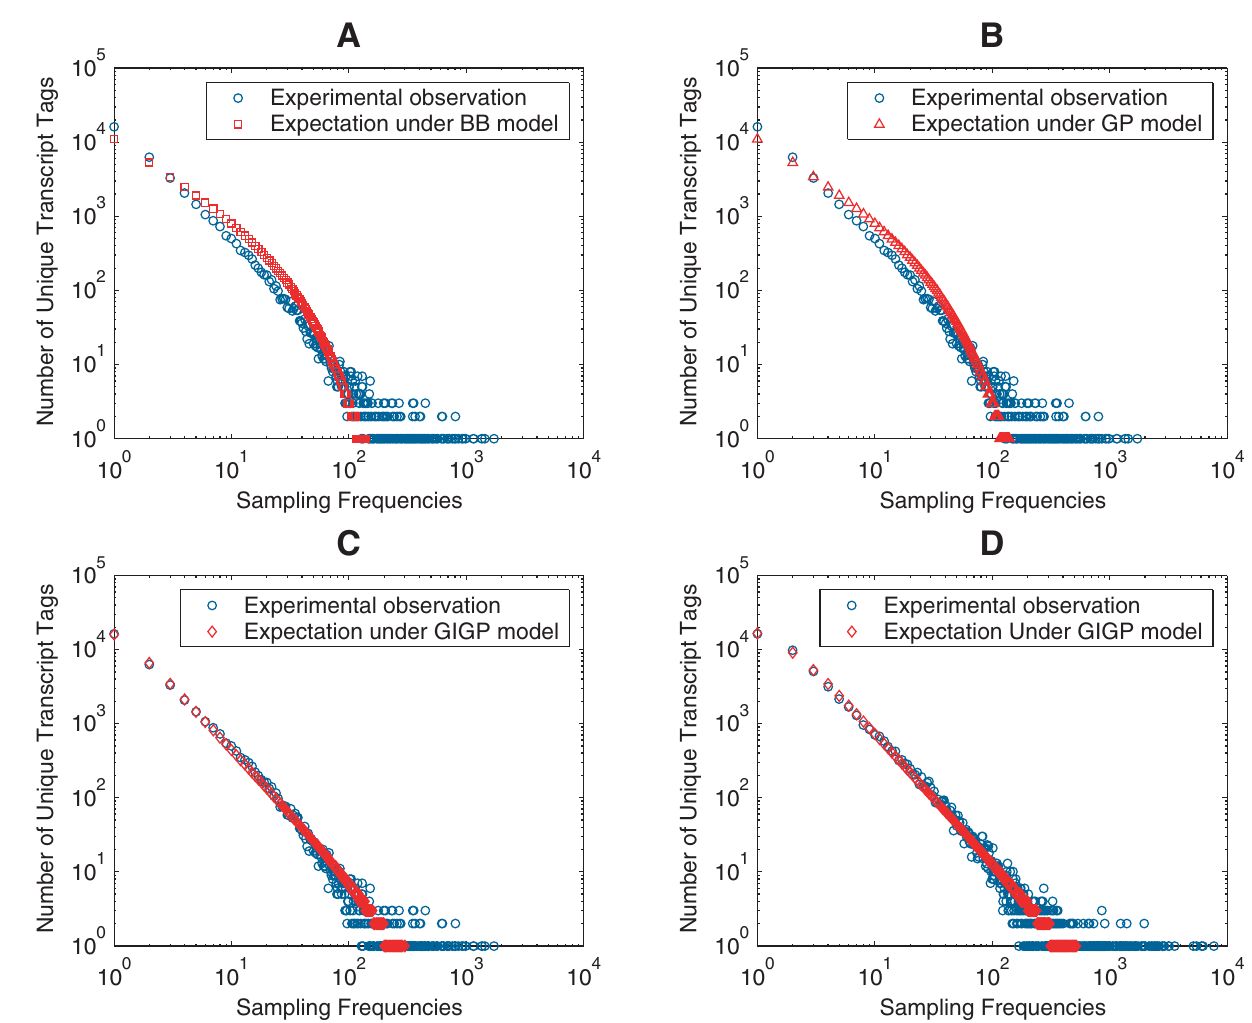
Figure 1. The expected FOF plotted against experimental observations. Both axes are in logarithmic scale to make FOF data more legible. The expected FOFs under BB (A) and GP (B) models are plotted against the experimentally observed FOF from Lib843. The expected FOF under GIGP model is plotted against the experimental observations from Lib843 (C) and the pooled library (D).